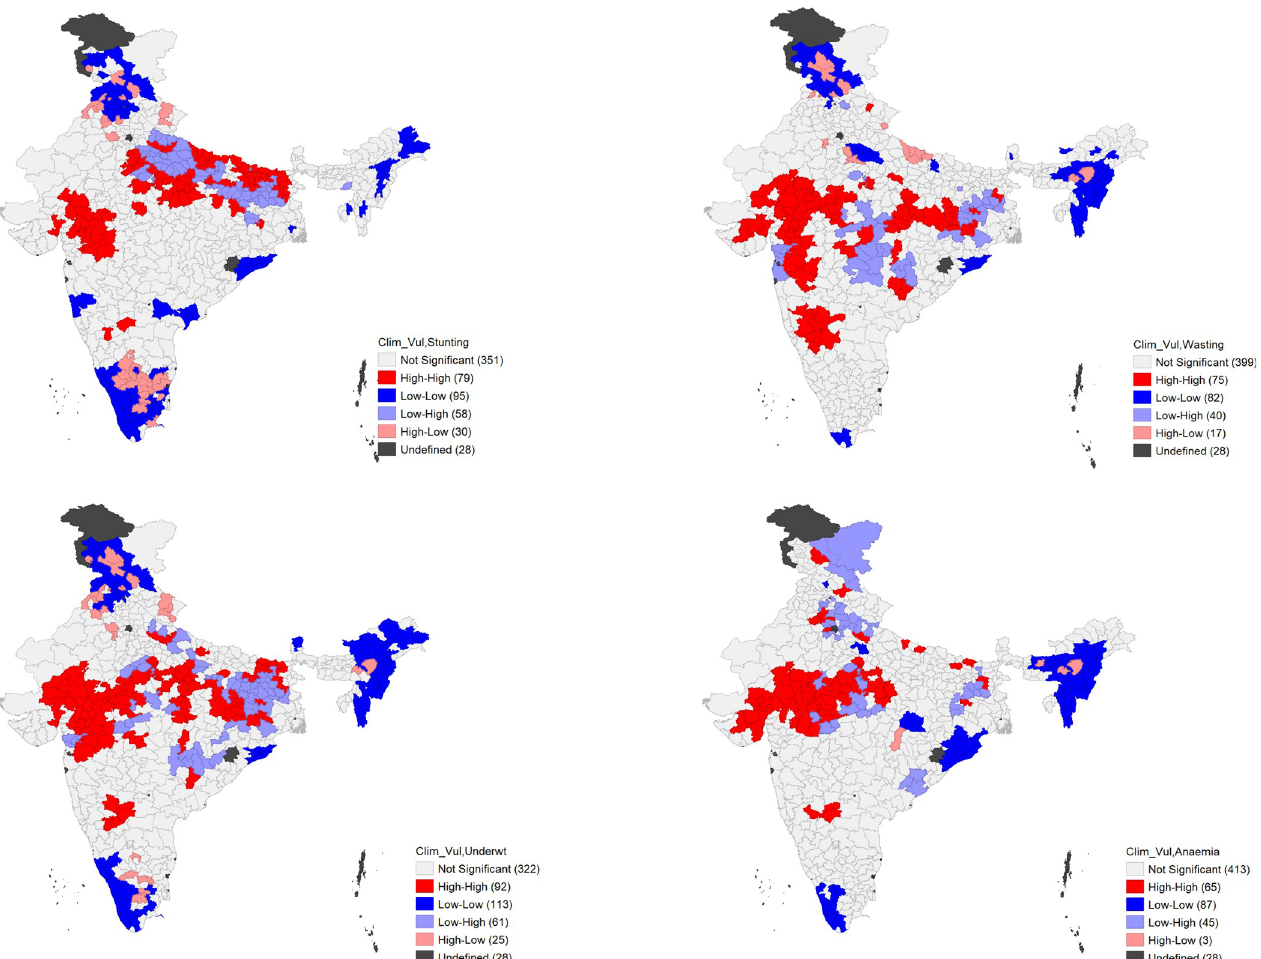
Fig 2. Bivariate LISA-based maps highlighting hotspots and coldspots in spatial correlation between the degree of vulnerability and child malnutrition.